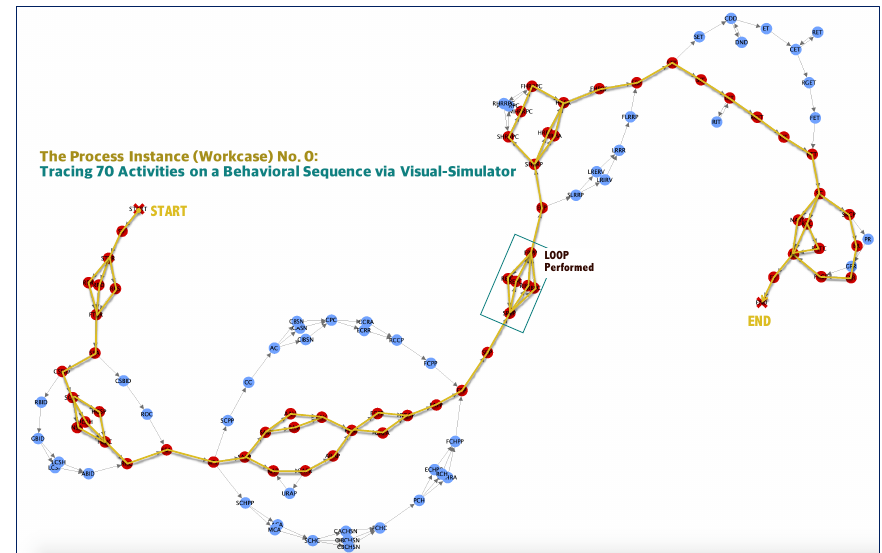
Figure 7. The interactive and visual analysis of behavioral sequences of the rediscovered process